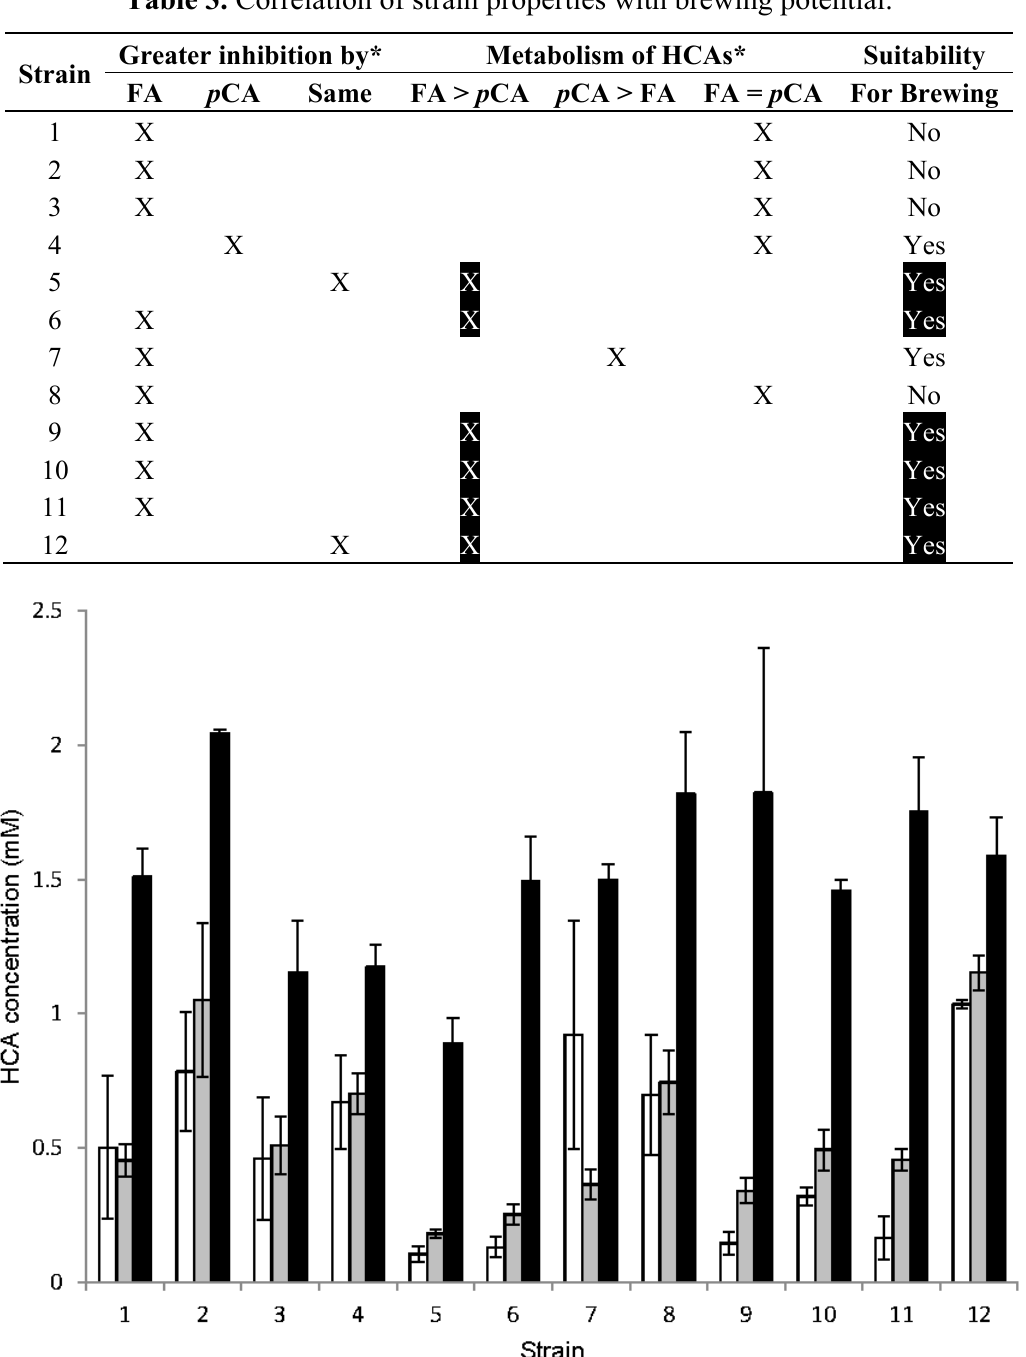
Table 3. Correlation of strain properties with brewing potential.